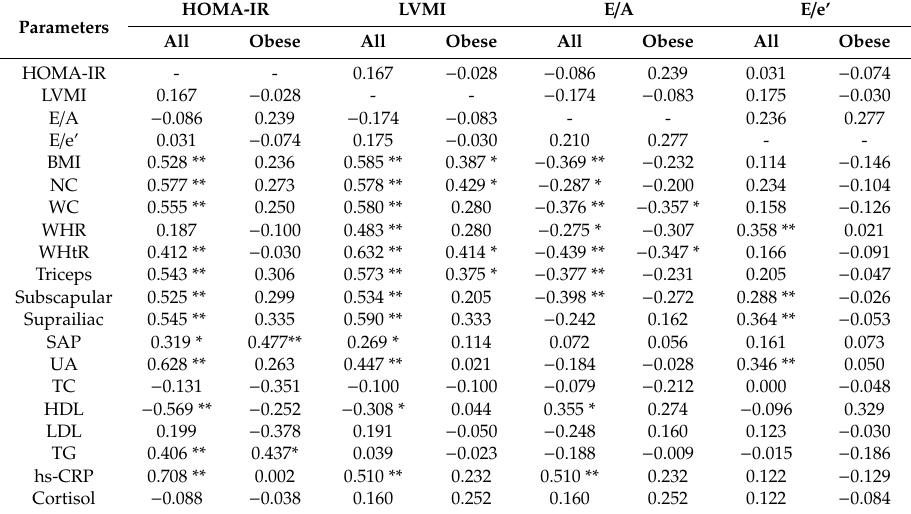
Table 4. Correlation between anthropometric and cardiometabolic factors and homeostatic model assessment of insulin resistance (HOMA-IR), left ventricular mass index (LVMI), E / A, E / e’. Parameters